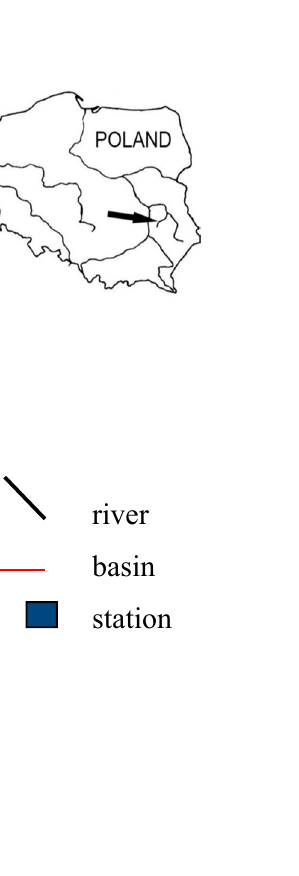
Figure 1. The hydrographic network of the Bystrzyca river basin. Table 1. Location of the station in the Bystrzyca river basin.